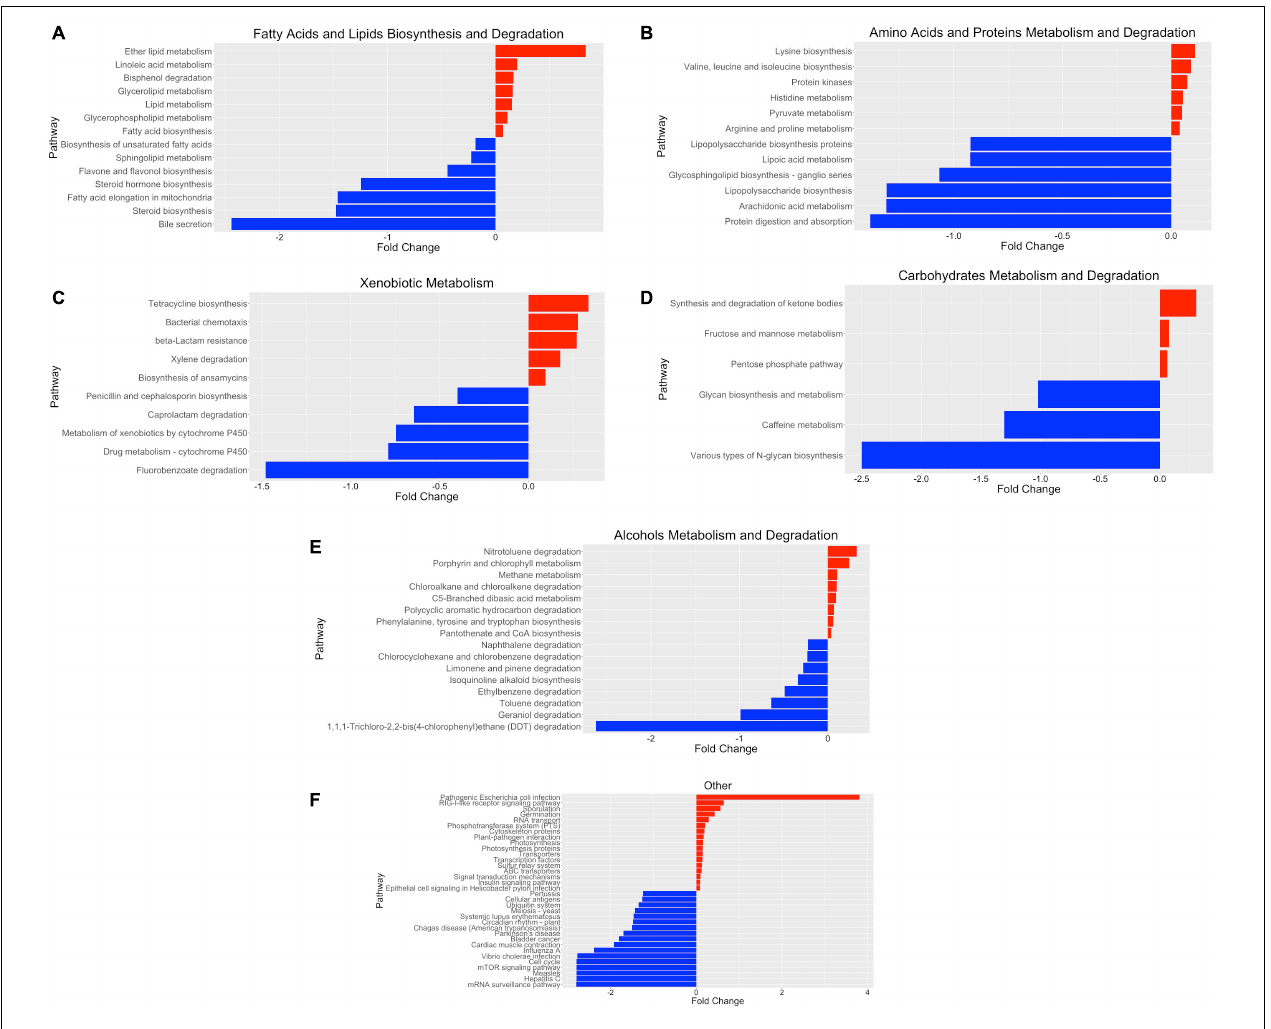
FIGURE 3 | Functional characterization of SARS-CoV-2-infected and SARS-CoV-2-non-infected microbiomes based on PICRUSt analyses of 16S data. (A) Fatty acid and lipid biosynthesis and degradation, (B) amino acid and protein metabolism and degradation, (C) xenobiotic metabolism, (D) carbohydrate metabolism and degradation, (E) alcohol metabolism and degradation, and (F) other pathways. The bar plot reports the fold change of the pathway and the p -value < 0.05, adjusted for gender and age group via a likelihood ratio test—log2fold change in the relative abundance of operational taxonomic units (OTUs) of cases over controls. A positive log2 fold change is relative abundance in cases compared to controls. A negative log2 fold change is represented as the blue plot. A positive log2 fold change is represented as the red plot. The p -value of each associated pathway is provided in Supplementary Table 5 . Please refer to Supplementary Figure 2 for an enlarged